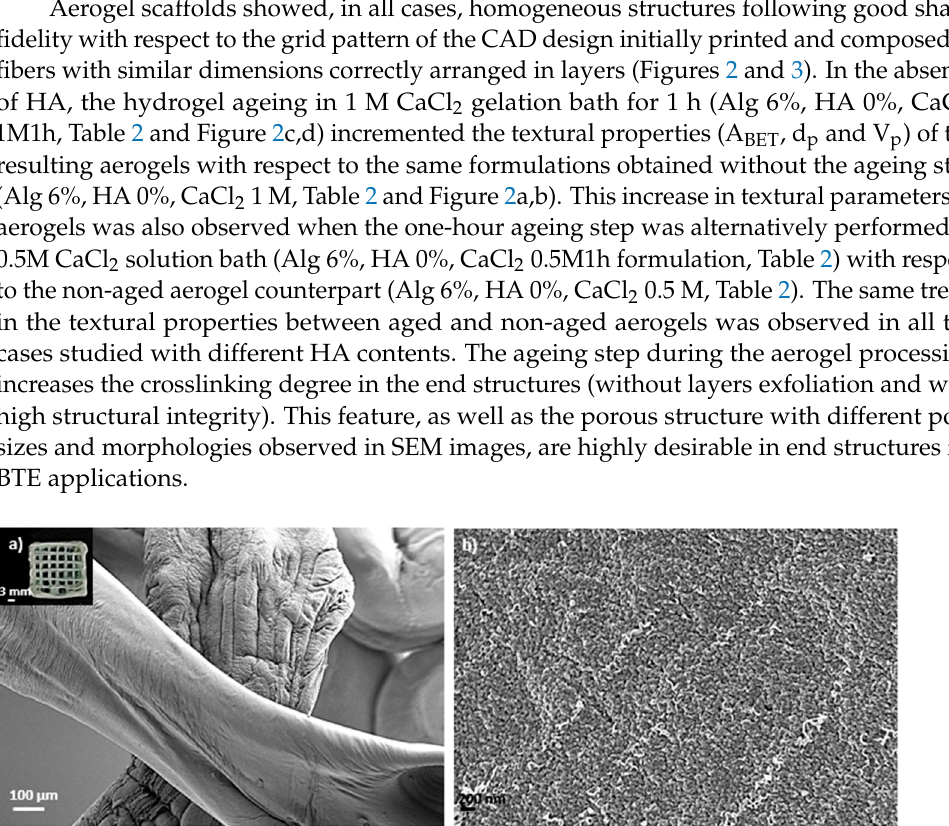
Figure 1. Rheological characterization of alginate-HA inks: ( a , b ) Time variation of storage and loss moduli and ( c ) overall viscosity variation with respect to the shear rate for different alginate-HA ink formulations.